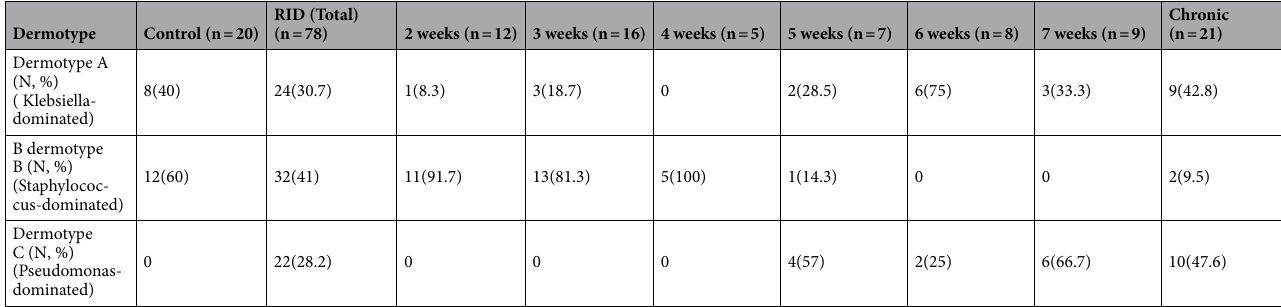
Table 3. Summary of case number in each